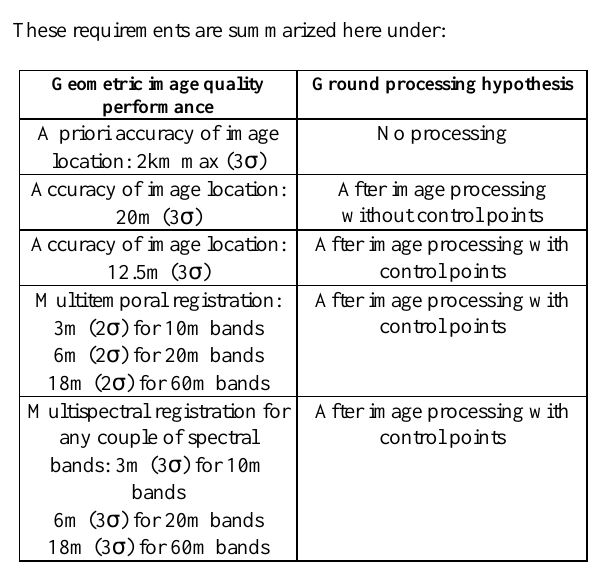
Table 3: Geometric image quality requirements The accuracy of the image location, without ground control points, is very good with regard to the pixel size and should Table 2: Sentinel-2 spectral bands definition and Signal to noise satisfy most of the applications. However we will see ratio requirements for the mission